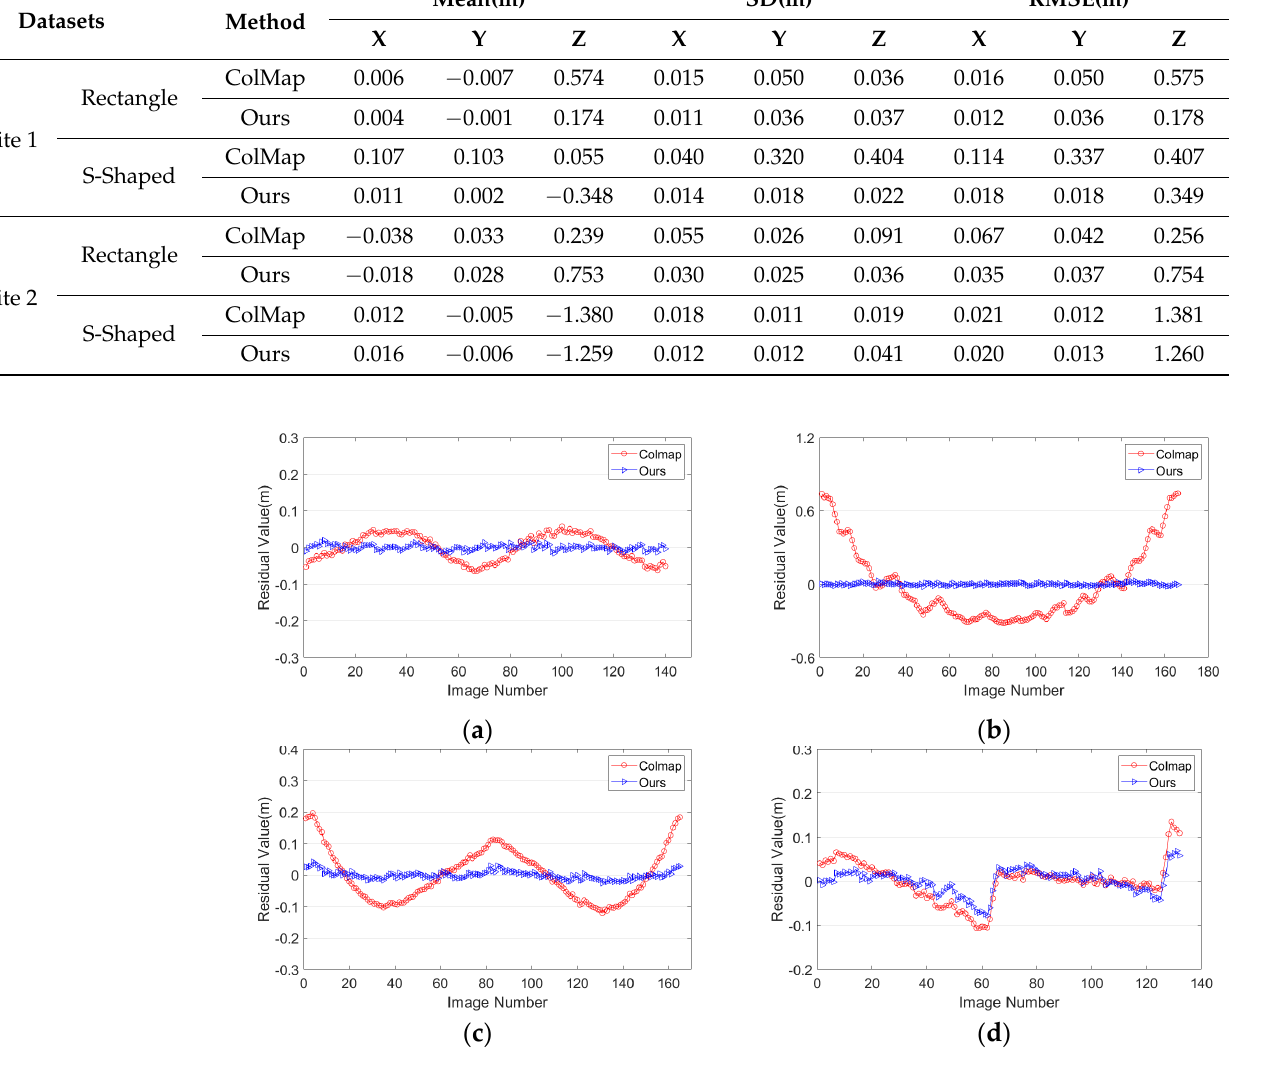
Figure 9. The coordinate offsets in the vertical direction between image projection center and differential GNSS location. ( a , b ) The offsets in the vertical direction with the rectangle dataset and S-shaped dataset in test site 1; ( c , d ) the offsets in the vertical direction with the rectangle dataset and S-shaped dataset in test site 2.